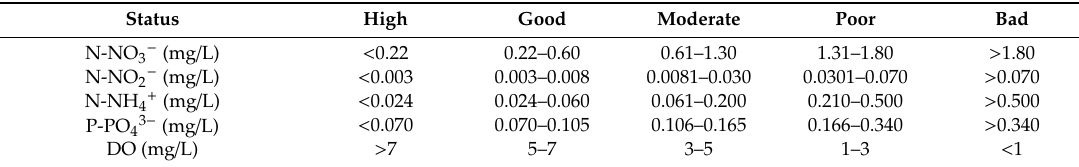
Table 4. Quality status in rivers based on the Nutrient Classification System (NCS) [89] (copyright permission see Supplementary Materials) and dissolved oxygen concentrations